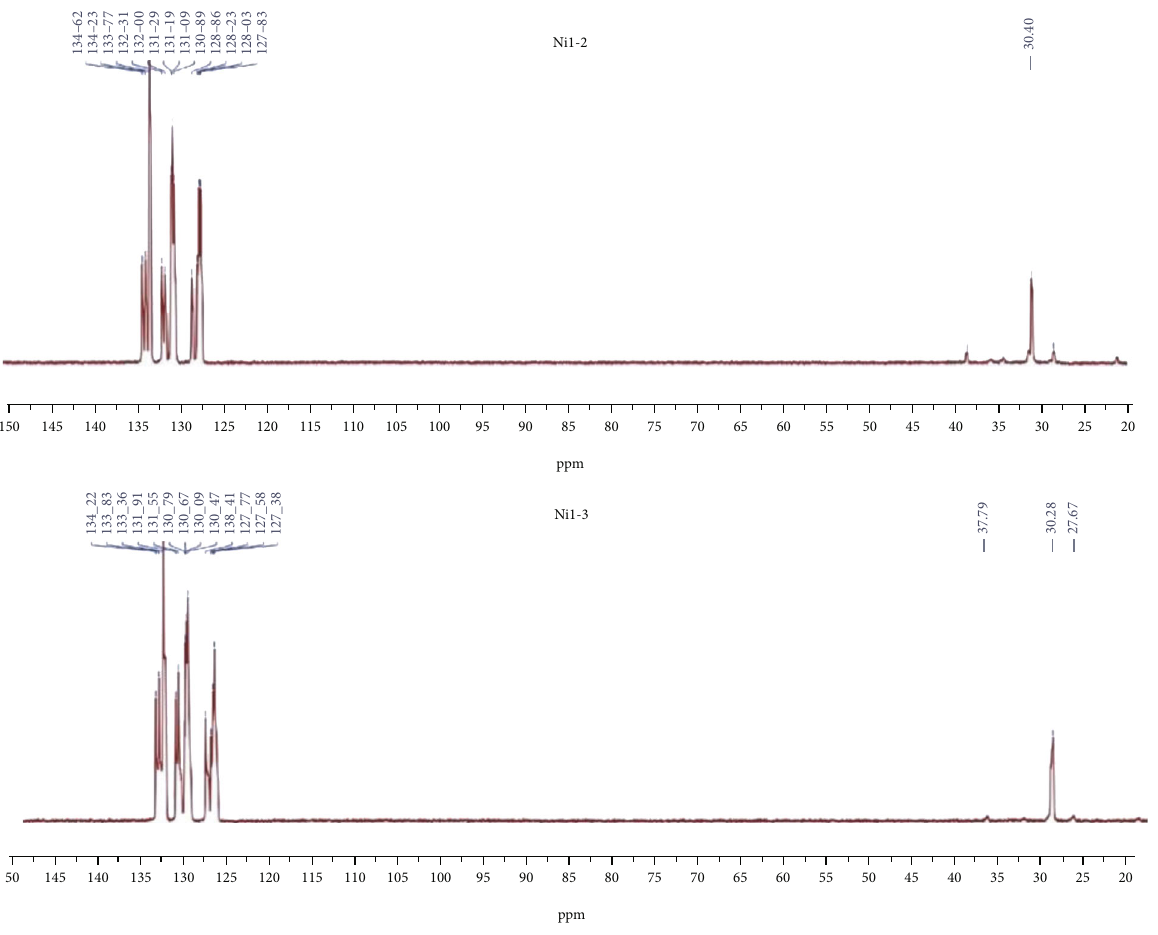
Figure 5: [13]CNMR spectrum for synthetic